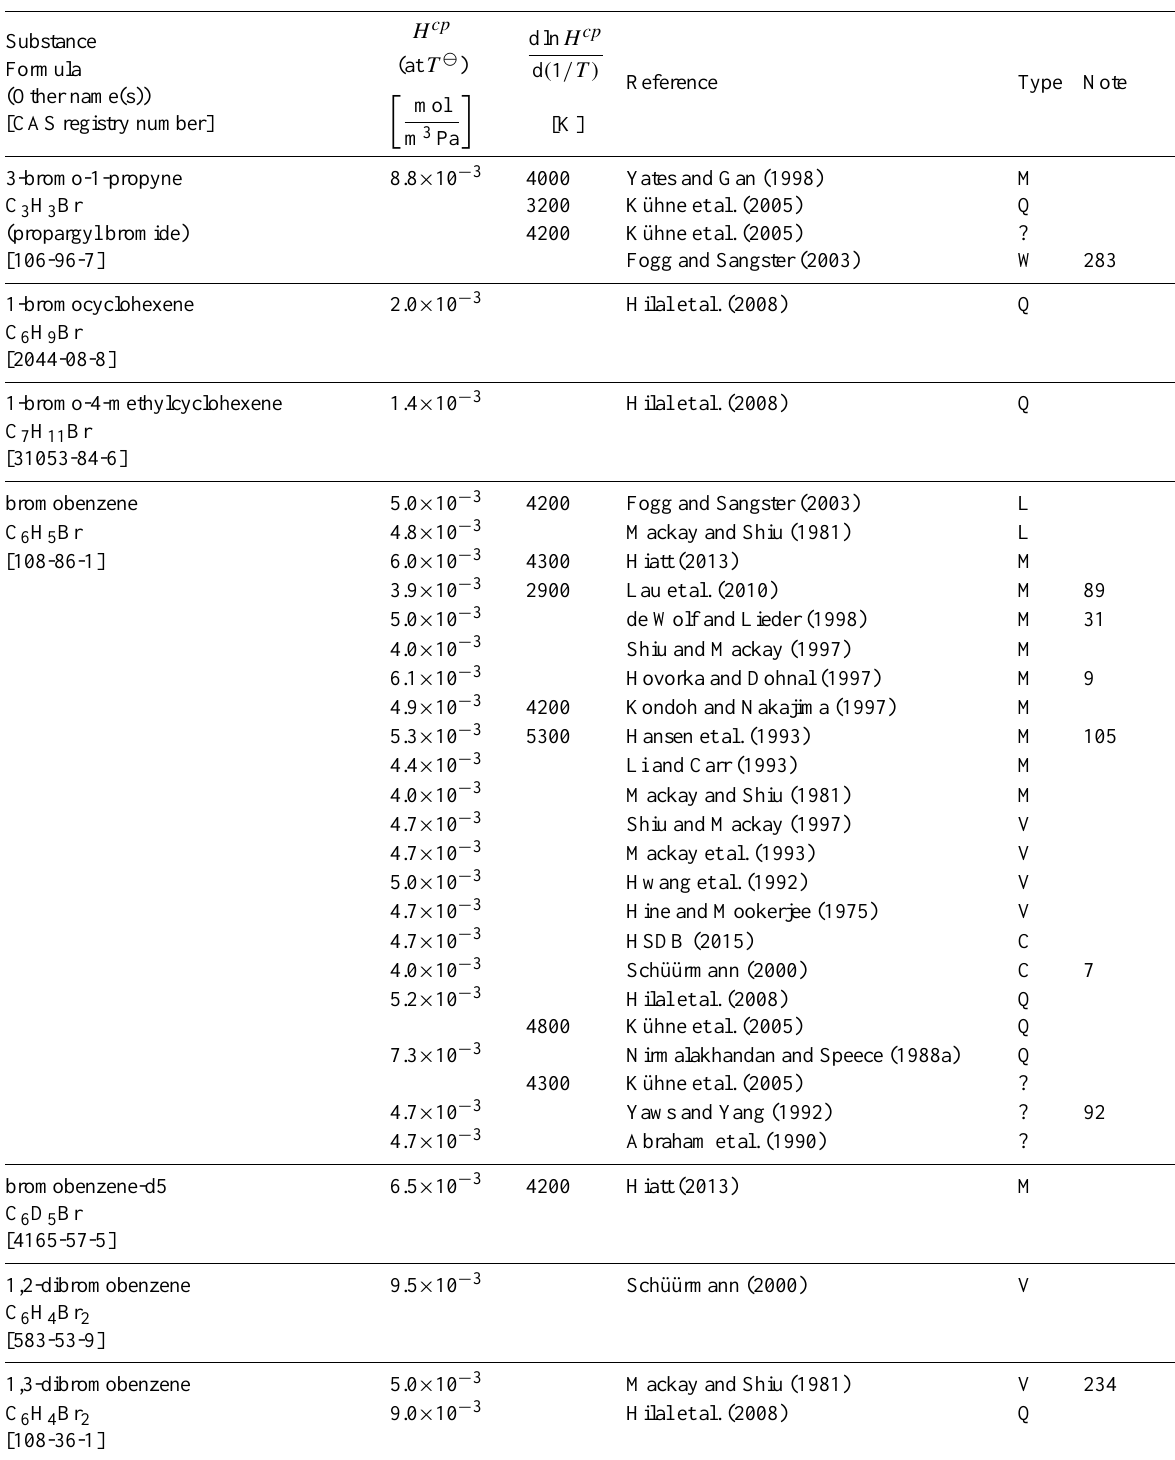
Table 6: Henry’s law constants for water as solvent